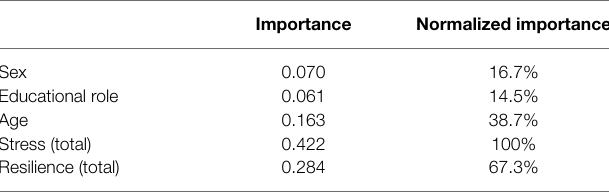
TABLE 3 | Independent variable